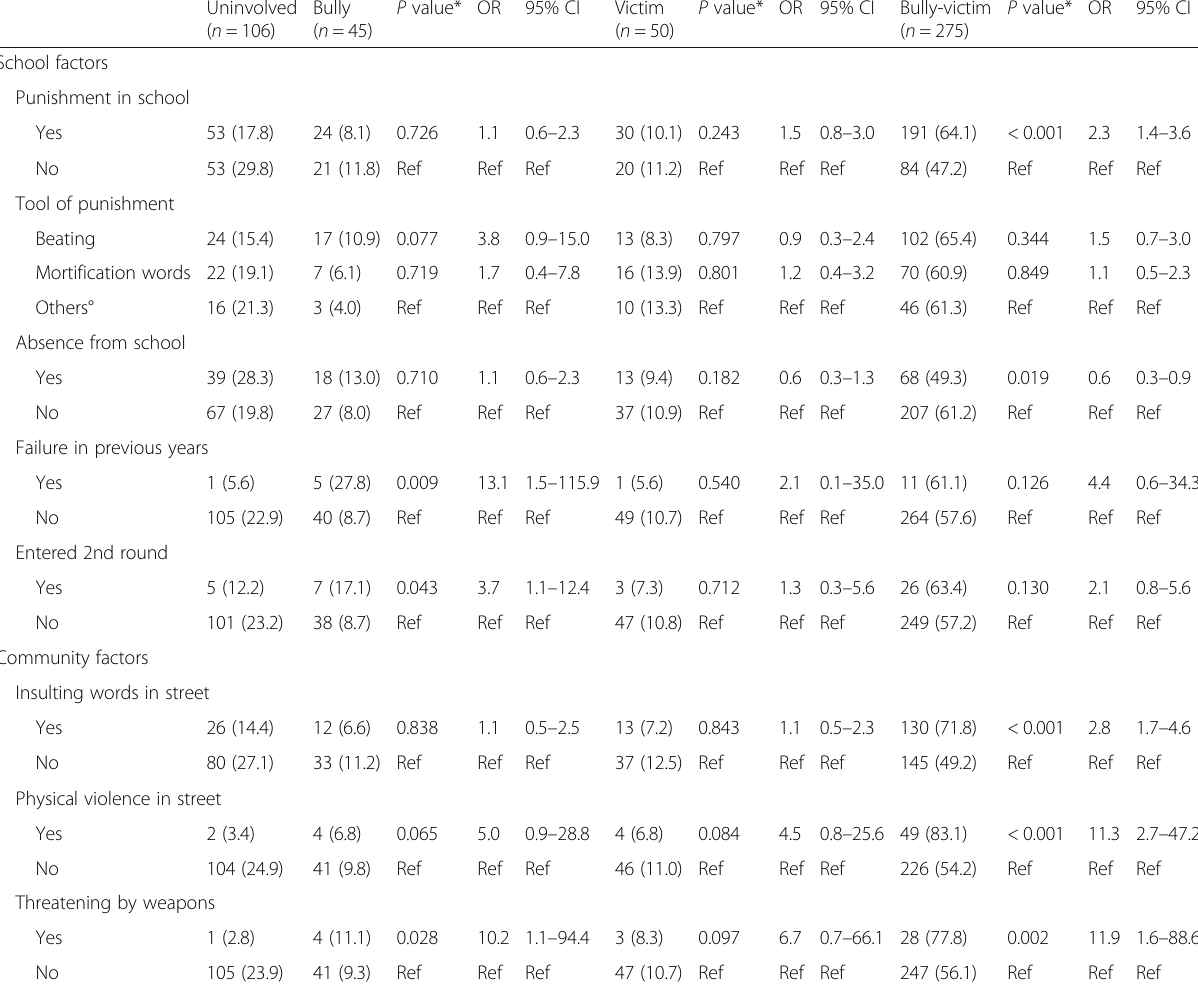
Table 3 School and community factors associated with bullying behavior among the studied group